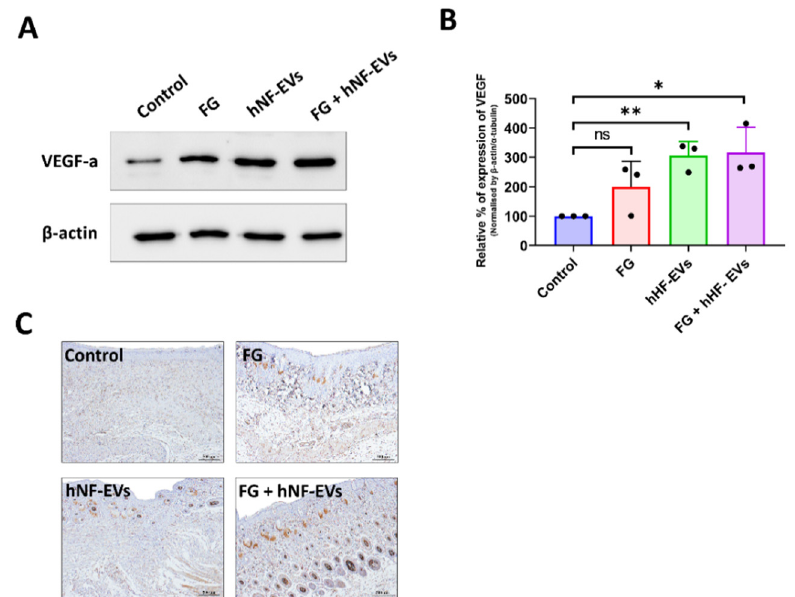
Figure 9. The promotion of angiogenesis by the hNF-EV treatment in wounds of mice. ( A ) Western blot analysis of VEGF and CD31 levels in wounds at day 16 treated with controls, FG, hNF-EVs, and FG + hNF-EVs. β -actin was used as a loading control. ( B ) Quantification of the band intensity of VEGF in the wound skin of mice treated with control, FG, hNF-EVs, and FG + hNF-EVs at day 16 (mice: n = 2 or wound: n = 3) using the GelQuantNet software; the mean and the SD of experiments are plotted. ( C ) CD31 IHC staining in wound sections treated with control, FG, hNF-EVs and FG + hNF-EVs at day 16 (scale bar = 500 µ m). * p < 0.05; ** p < 0.01 and ns: not significant. A student’s t -test was